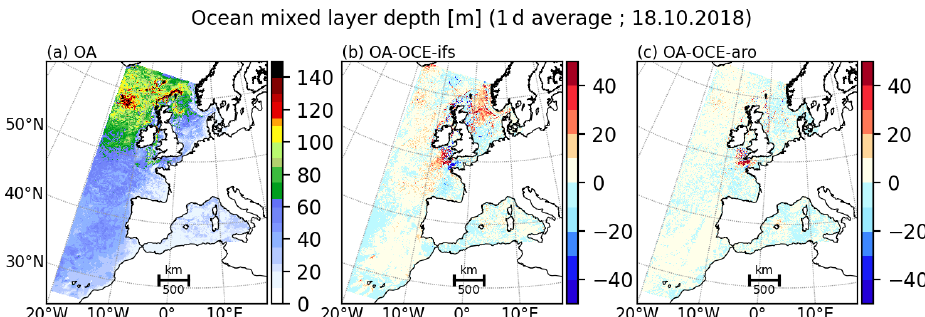
Figure 9. Daily-averaged oceanic mixed layer depth (m) simulated by OA simulation on the last day of simulation (a) and differences (in metres) with OCE-ifs- and OCE-aro-forced simulations (b, c) .